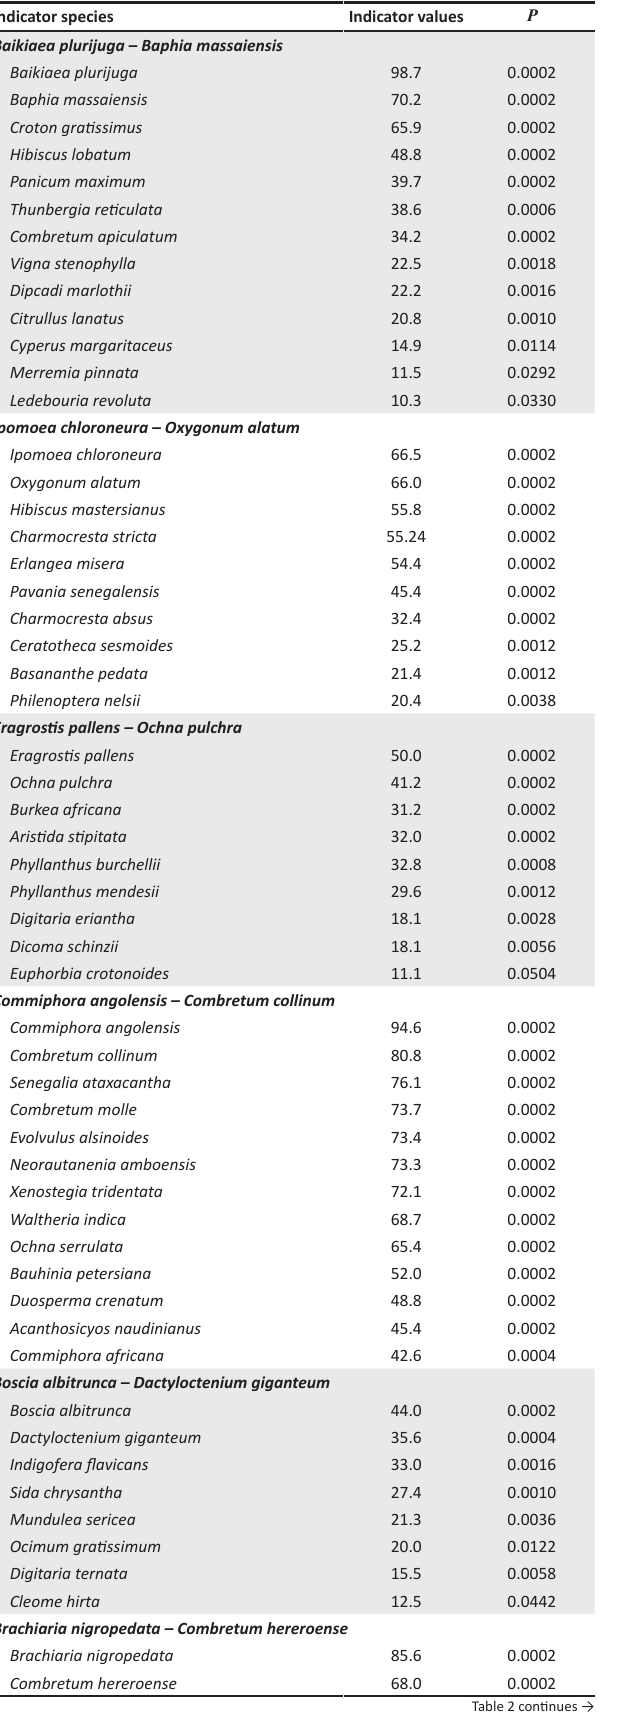
TABLE 2: Indicator species characteristics for 15 class divisions of plant communities in the Savuti-Mababe-Linyanti ecosystem (northern Botswana). Indicator species Indicator values P